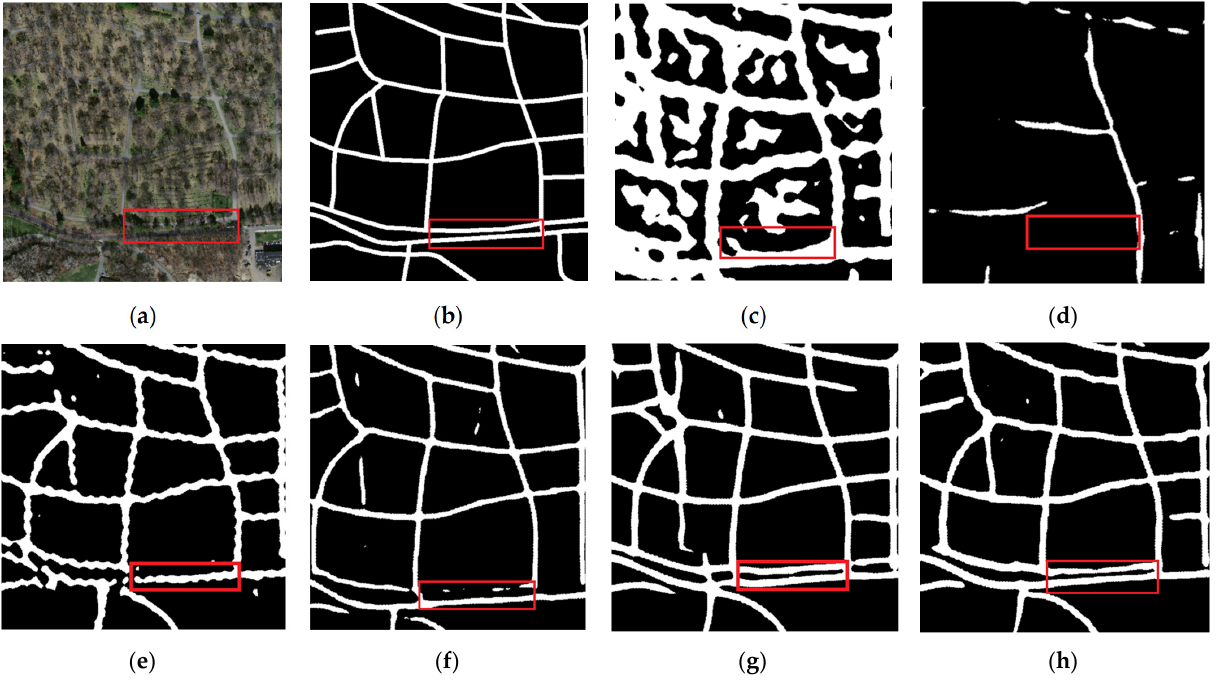
Figure 7. Results of road extraction in occlusion scene. ( a ) Image; ( b ) Label; ( c ) DeepLabv3+; ( d ) U ‐ Net; ( e ) HRNetV2; ( f ) D ‐ LinkNet; ( g ) RefineNet; and ( h ) MSPFE ‐ Net.( Red squares represent key areas.)